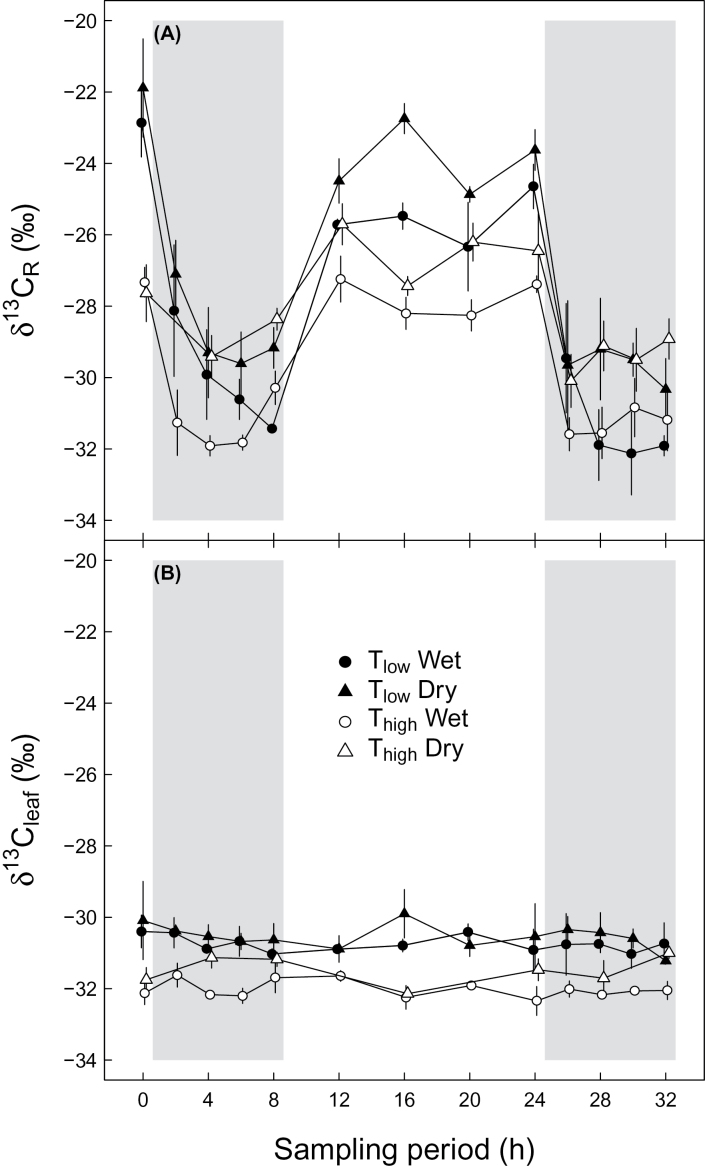
Daily cycles of the carbon isotopic composition of (A) leaf dark-respired CO2 (δ
13
C
R) and (B) bulk leaves (δ
13
C
leaf) under different environmental conditions during the sampling period. Potato plants were treated with a combination of Tlow (low temperature; closed symbols), Thigh (high temperature; open symbols), and wet (circles) or dry (triangles) conditions. Grey areas indicate nighttime. Means ±SE are given (n=3).